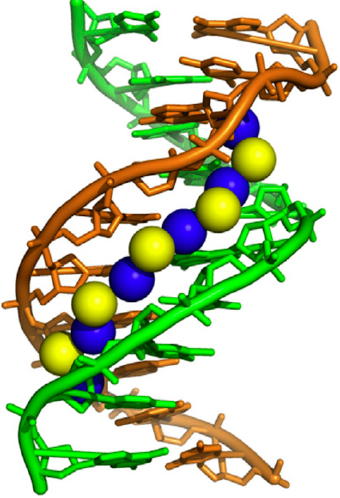
Figure 1. A 16 bp duplex solved at 1.6 Å resolution [9] showing the apolar and polar surface char- acteristics. Apolar: carbons in white, methyl groups of T in green. Polar: red (negative) and blue (positive). Phosphate groups in yellow. Water molecules are shown as cyan dots. A regular array of eight waters can be seen covering six bp (AATGTT) in the central minor groove. Reprinted from Ref. [22].